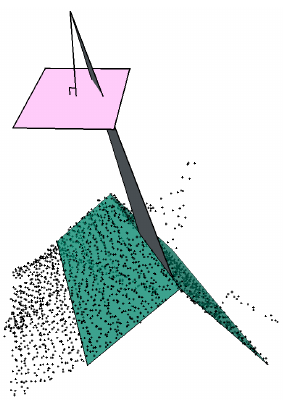
Figure 6. Line as a link between Photo and LIDAR